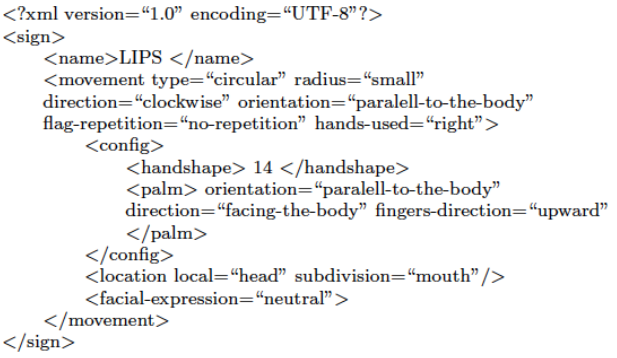
Figure 3 – XML Document of LIPS